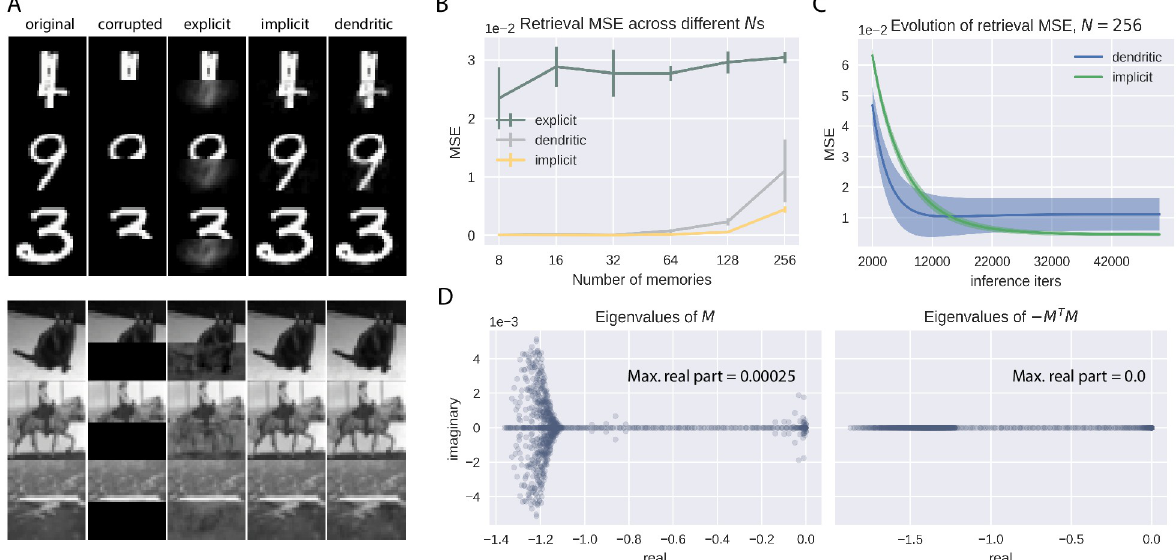
Fig 4. Performance of the single-layer covPCNs in AM of structured images. A: Examples of retrieved MNIST (top) [19] and grayscale CIFAR10 (bottom)[20] images by explicit, implicit and dendritic models. All models here are trained to memorize 64 images. For MNIST, the networks have d = 784 neurons; for grayscale CIFAR10, d = 1024. B: Retrieval mean squared errors (MSEs) of the single-layer models across multiple numbers of training memories ( N ). C: Evolution of the retrieval MSEs of the implicit and dendritic models when N = 256. D: Example eigenspectra of the weight matrices defining the inferential dynamics for the dendritic (left) and implicit (right) covPCNs. Error bars obtained by 5 different seeds for image sampling. Please see main text for an explanation of the matrix M .